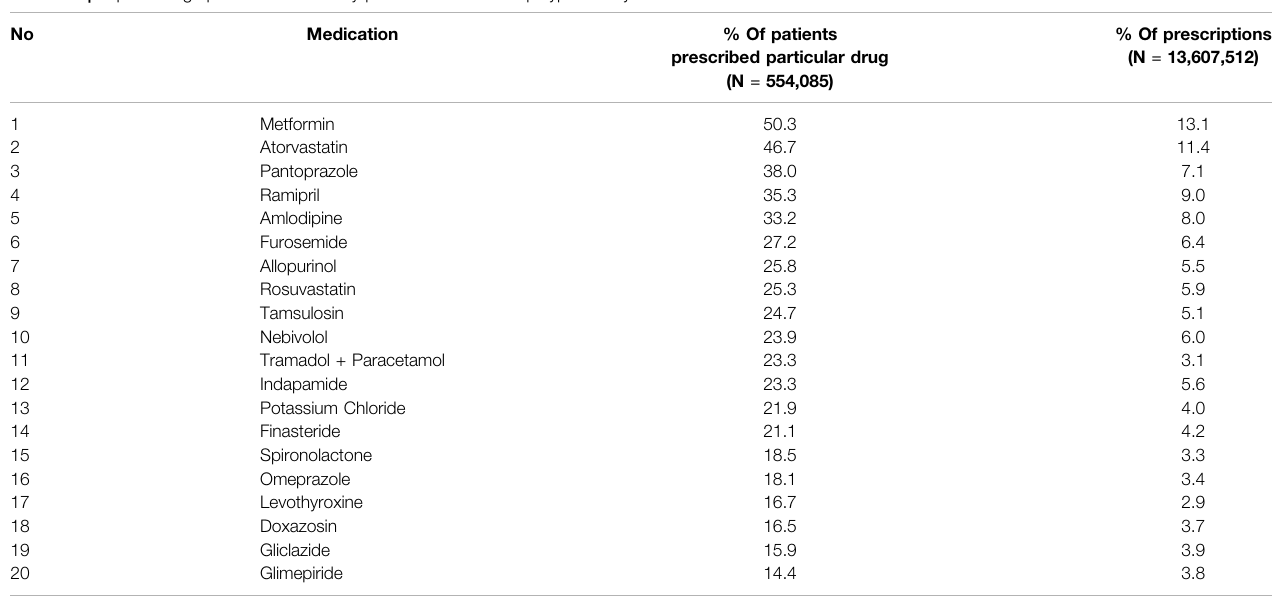
TABLE 2 | Top-20 drugs prescribed to elderly patients with chronic polypharmacy. No Medication % Of patients